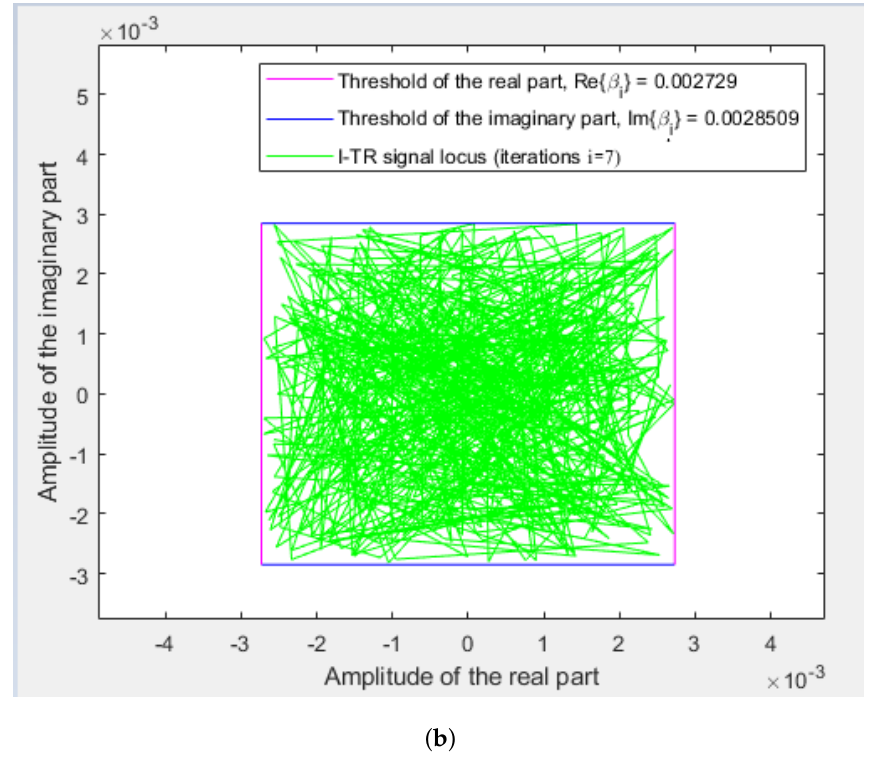
Figure 14. The power distribution locus for each subcarrier of the I–TR signal. ( a ) i = 1 ( b ) i = 7.